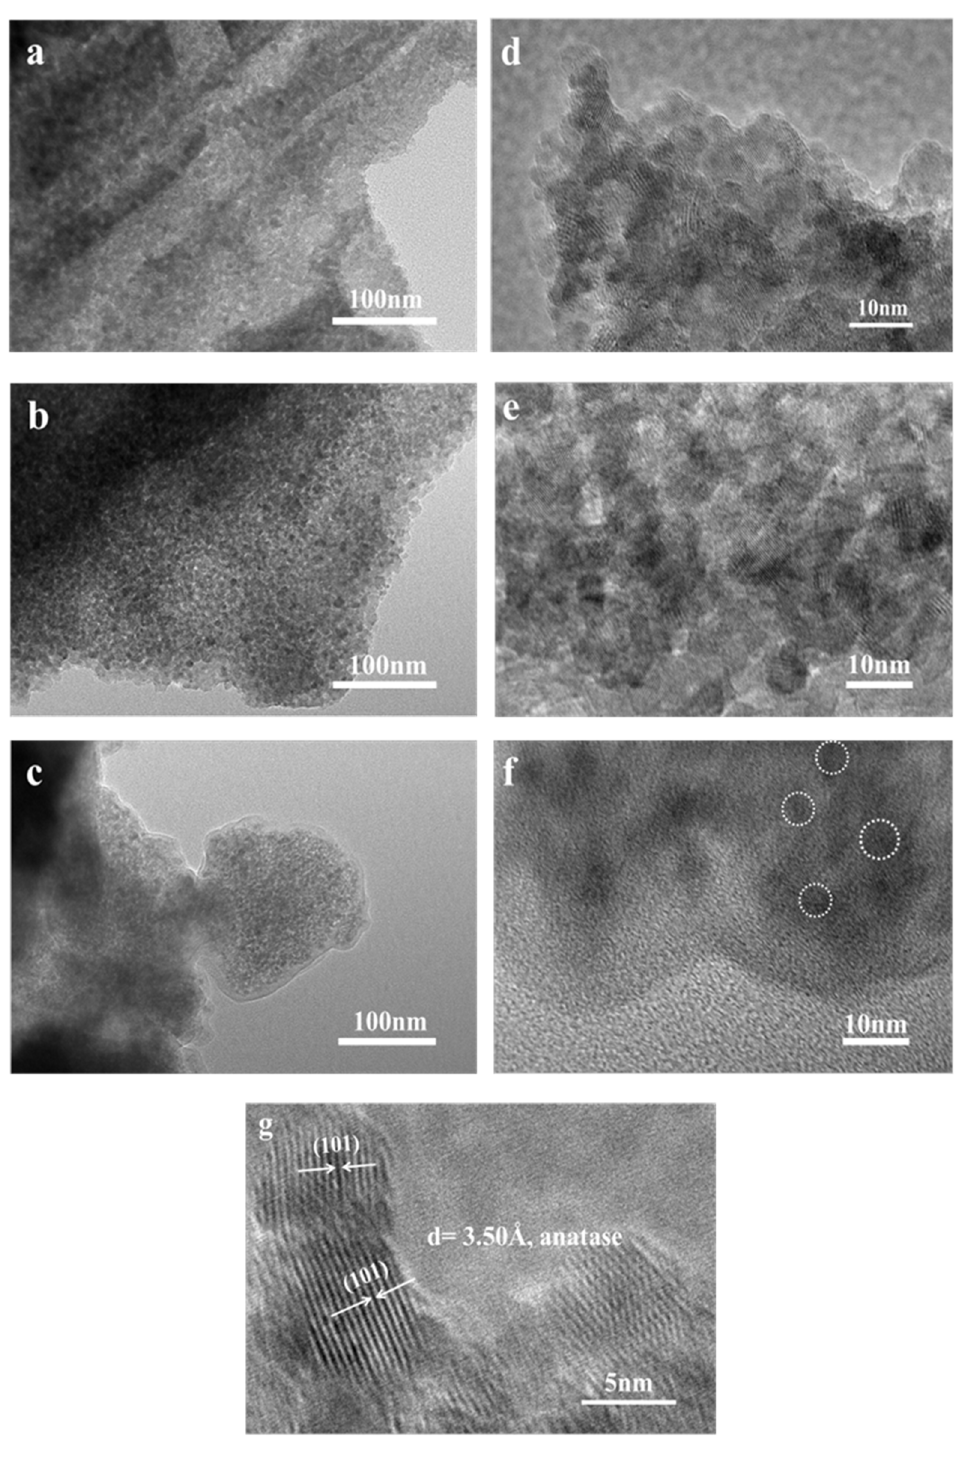
Figure 5. Transmission electron microscopy (TEM) and High-resolution TEM (HRTEM) images of ( a ), ( d ), and ( g ) R-TiO 2 /SiO 2 ; ( b ) and ( e ) WH-TiO 2 /SiO 2 ; ( c ) and ( f ) D-TiO 2 /SiO 2